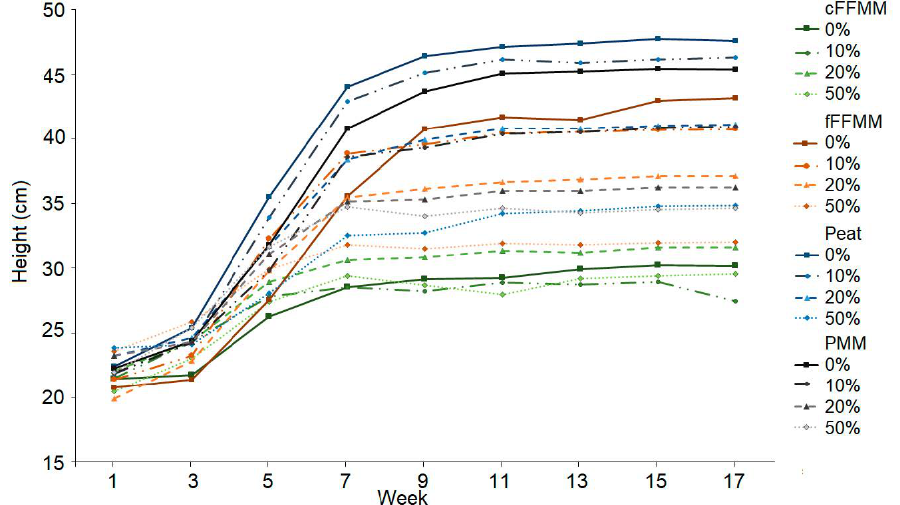
Figure 1. Height (cm) over time for each soil type and 0%, 10%, 20% and 50% wood amount. Values are averages. cFFMM, coarse forest floor ‐ mineral mix (green); fFFMM, fine forest floor ‐ mineral mix (orange); PMM, peat ‐ mineral mix (grey); peat (blue).